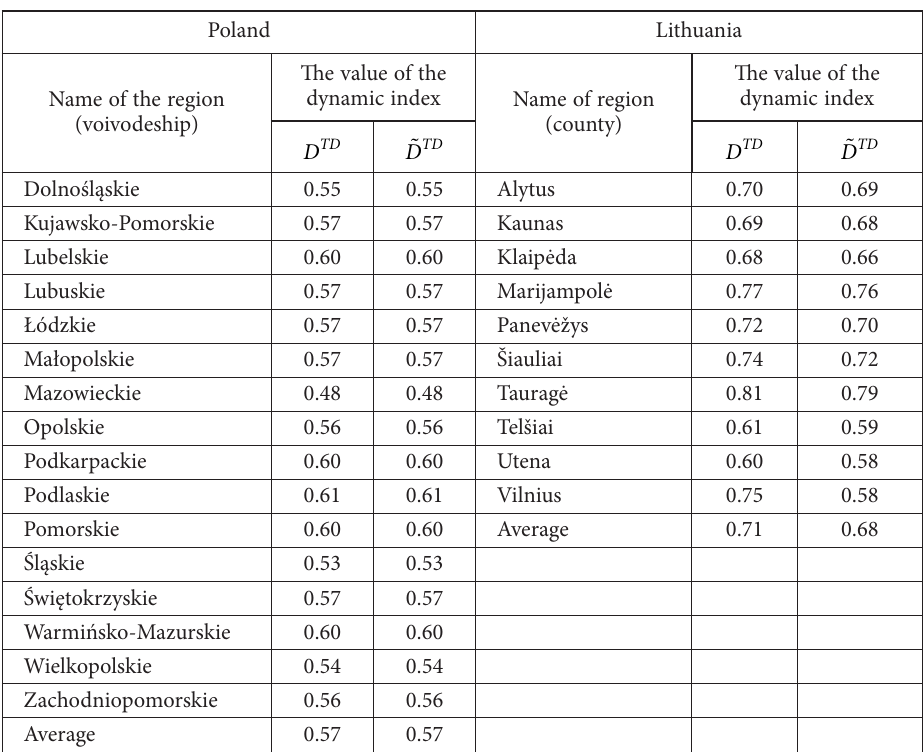
Table 6. Values of economic development dynamics of Polish and Lithuanian regions in 2008–2017 (source: compiled by